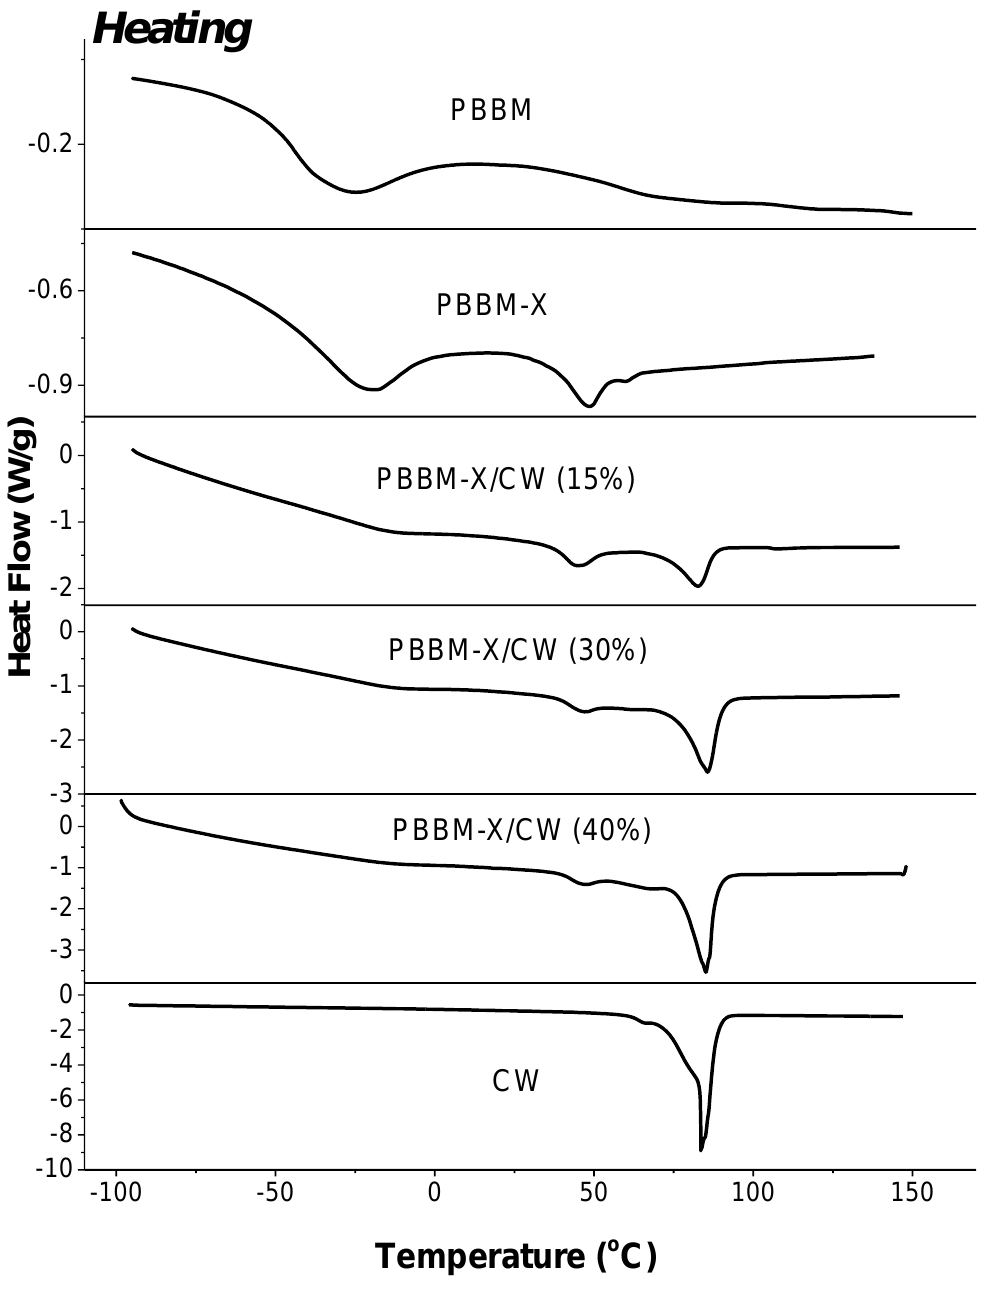
Figure 5. DCS heating traces for the bioplastics.